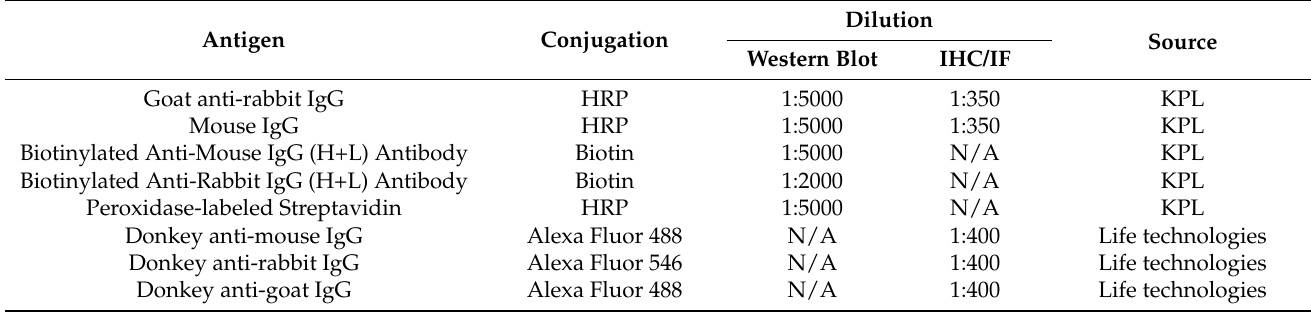
Table 2. The second